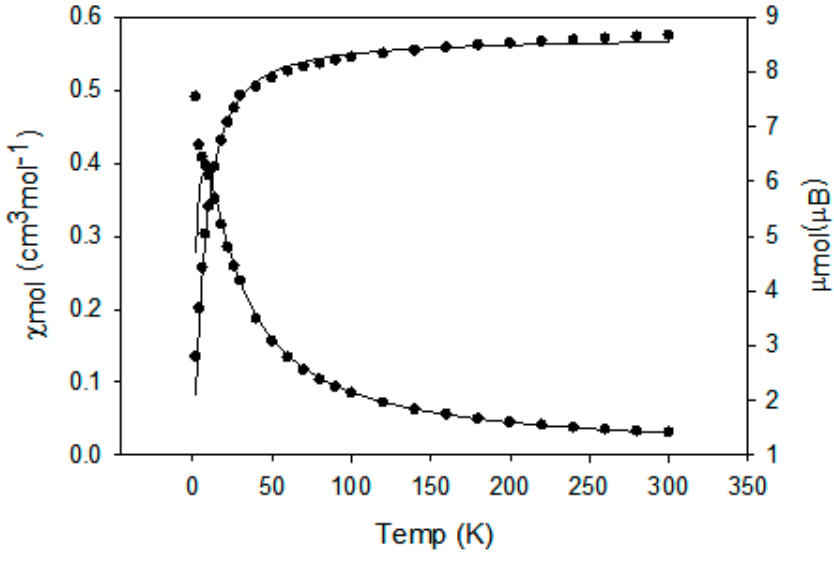
Figure 4. Plot of molar susceptibility and moment as a function of temperature.